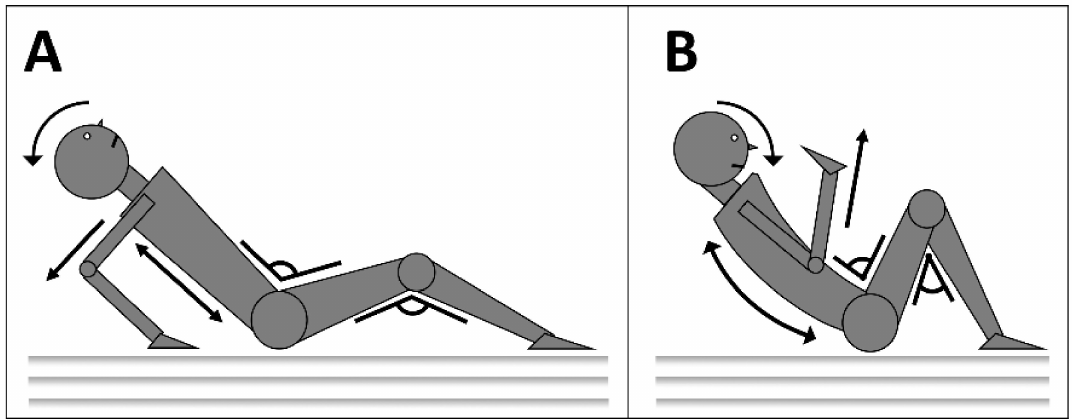
Figure 1. The figure illustrates the potentially harmful responses (PHR) ( A ) and protective responses ( B ) of the five body parts (head, back, upper limbs, hips and knees) assessed during a backward